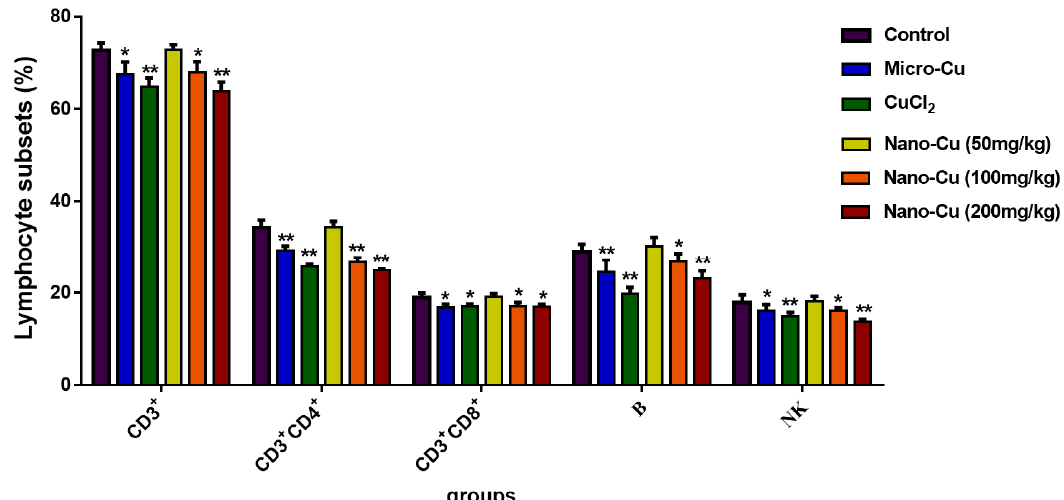
Figure 3. Lymphocyte subsets CD3, CD3CD4, CD3CD8, B, and NK cells in rats treated with oral administration for 28 consecutive days. * p < 0.05, and ** p < 0.01. Values represent means ± SD ( N =